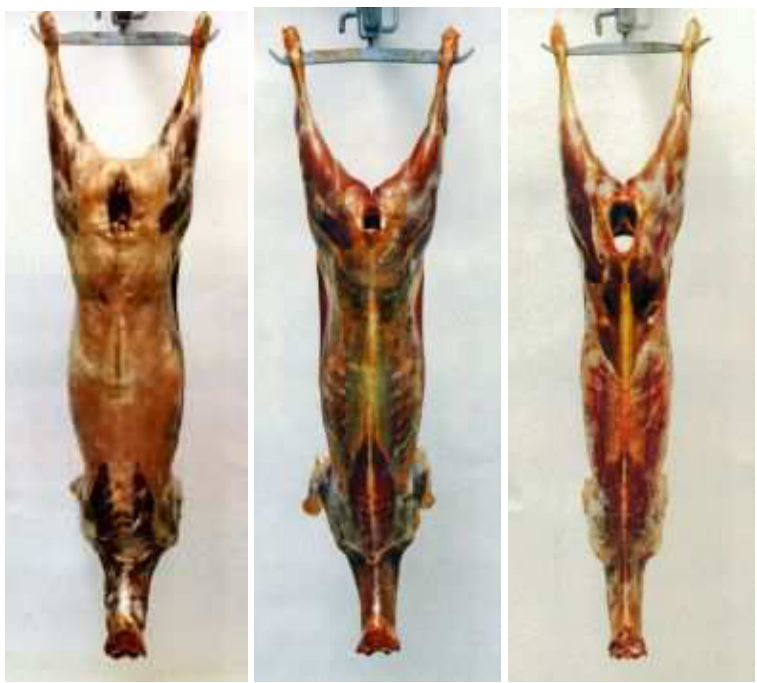
Fig. 2. Klassificeringsresultaten för renslaktkroppar varierar normalt mellan R och P på EUROP-skalan..